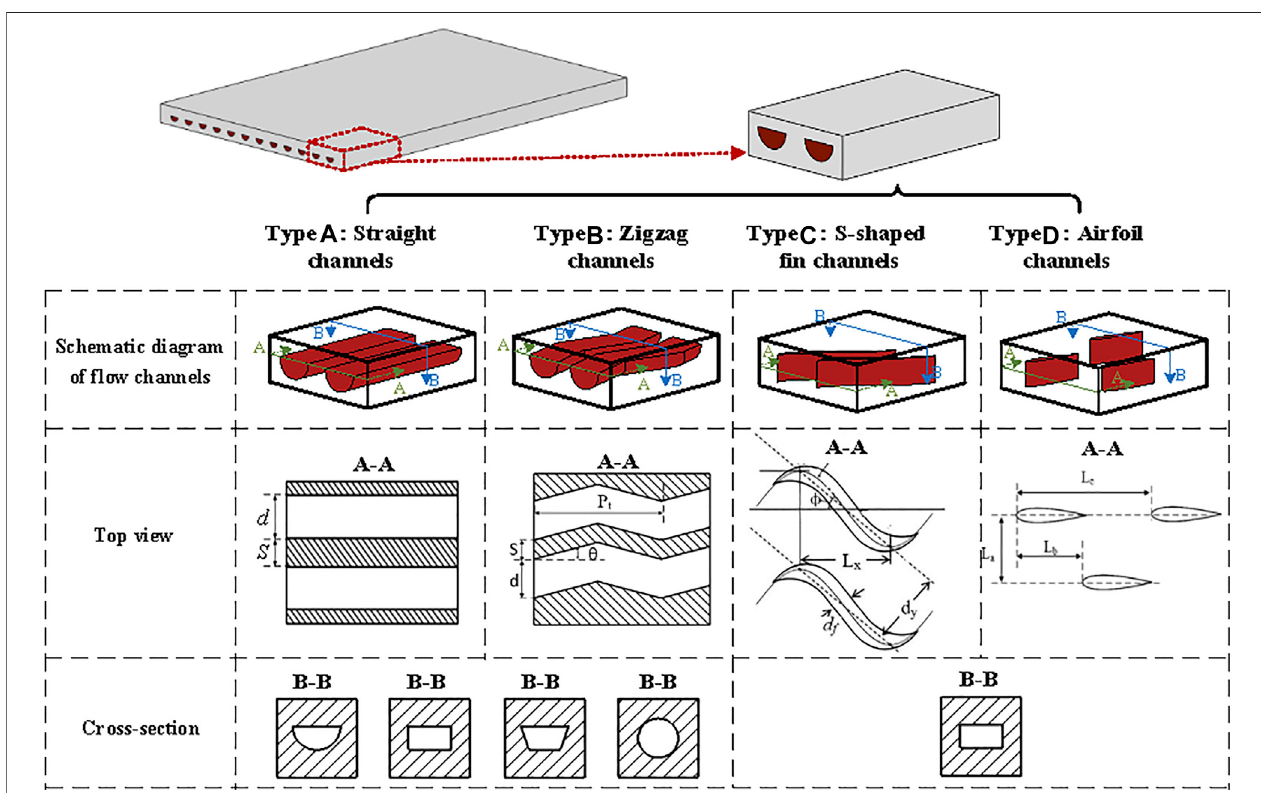
FIGURE 2 | Schematic diagram of the PCHE